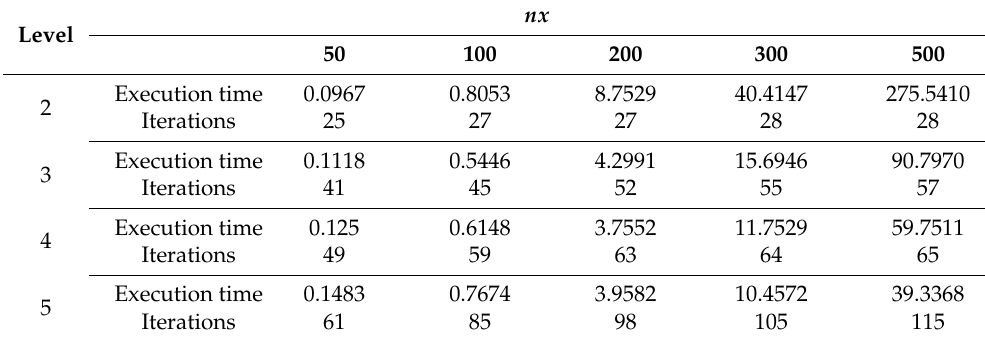
Table 1. Convergence behavior and performance of V cycle of AGAMG for 2D Poisson model problem.